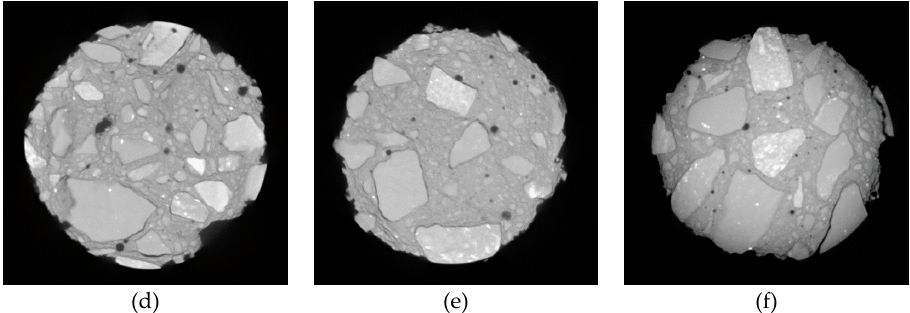
Figure 16. CT scanning images of di ff erent nano-particle added concrete subjected to 75 FTCs. Figure 16. CT scanning images of different nano-particle added concrete subjected to 75 FTCs. ( a ) 15 ( a ) 15 nm-NS (0.2%); ( b ) 15 nm-NS (0.6 %); ( c ) 30 nm-NS (0.2%); ( d ) 30 nm-NS (0.4%); ( e ) 30 nm-NT nm-NS (0.2%); ( b ) 15 nm-NS (0.6 %); ( c ) 30 nm-NS (0.2%); ( d ) 30 nm-NS (0.4%); ( e ) 30 nm-NT (0.2%); (0.2%); ( f ) 30 nm-NT (0.6%). ( f ) 30 nm-NT (0.6%). Figure 16. CT scanning images of different nano-particle added concrete subjected to 75 FTCs. ( a ) 15 Figure 16. CT scanning images of different nano-particle added concrete subjected to 75 FTCs. ( a ) 15 nm-NS (0.2%); ( b ) 15 nm-NS (0.6 %); ( c ) 30 nm-NS (0.2%); ( d ) 30 nm-NS (0.4%); ( e ) 30 nm-NT (0.2%); nm-NS (0.2%); ( b ) 15 nm-NS (0.6 %); ( c ) 30 nm-NS (0.2%); ( d ) 30 nm-NS (0.4%); ( e ) 30 nm-NT (0.2%); ( f ) 30 nm-NT (0.6%). ( f ) 30 nm-NT (0.6%).